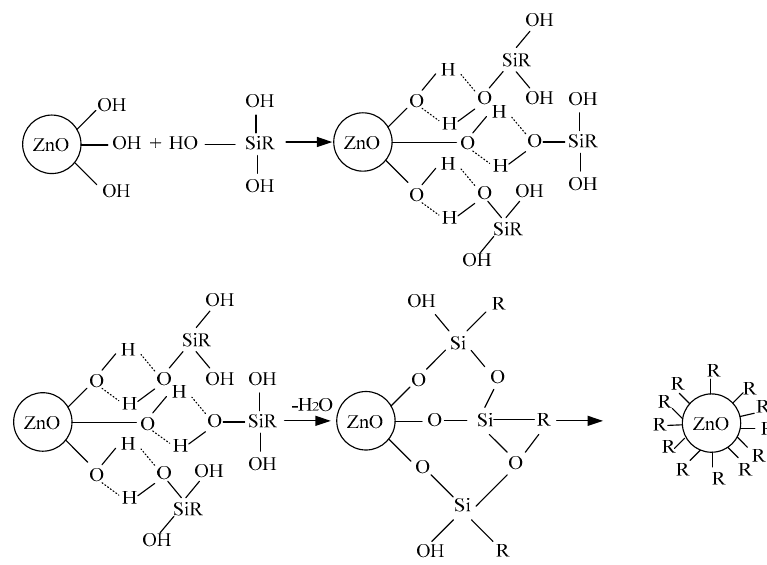
Figure 1. Surface modification of ZnO with silicane coupling agent (KH570).